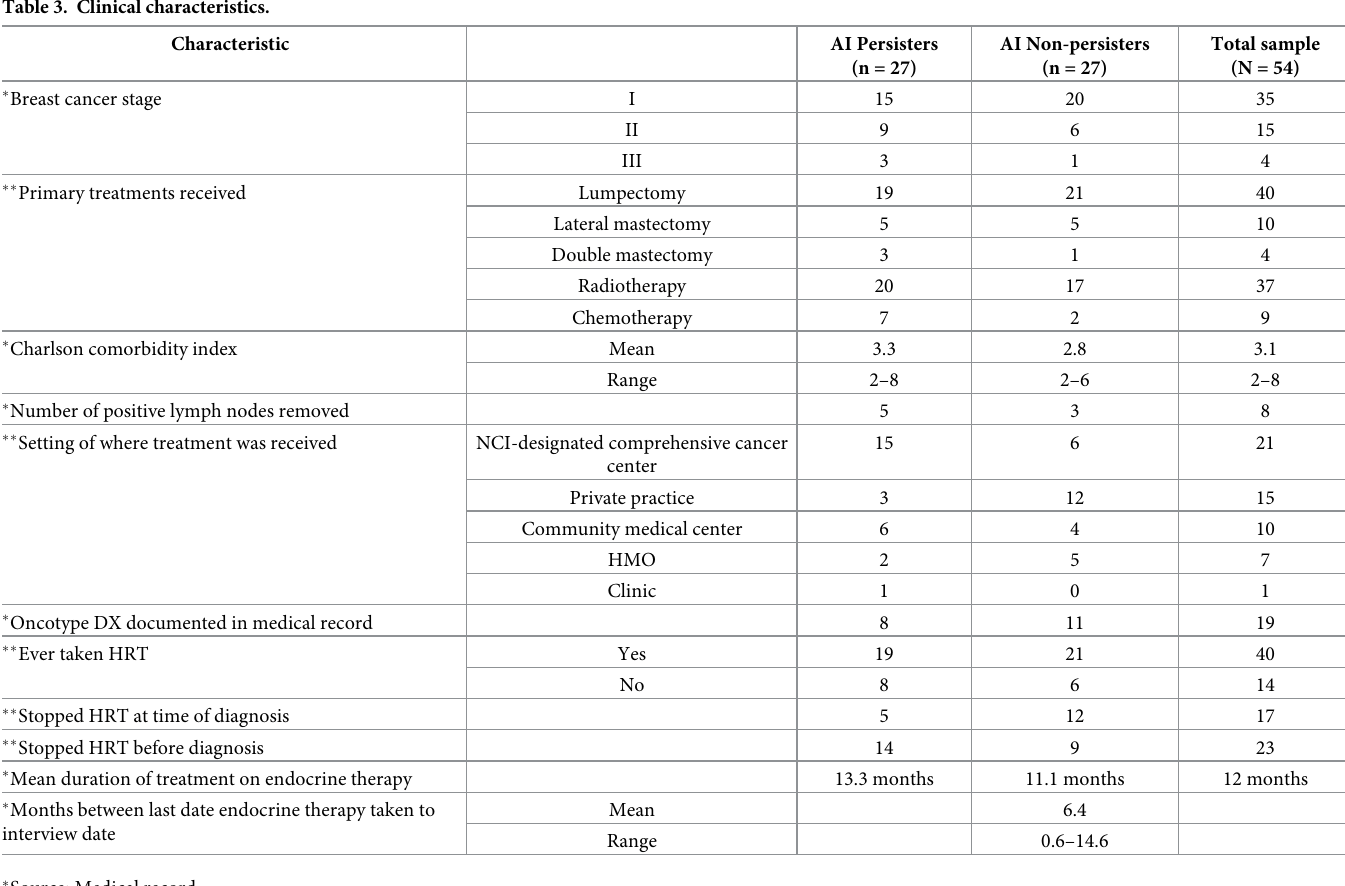
Table 3. Clinical